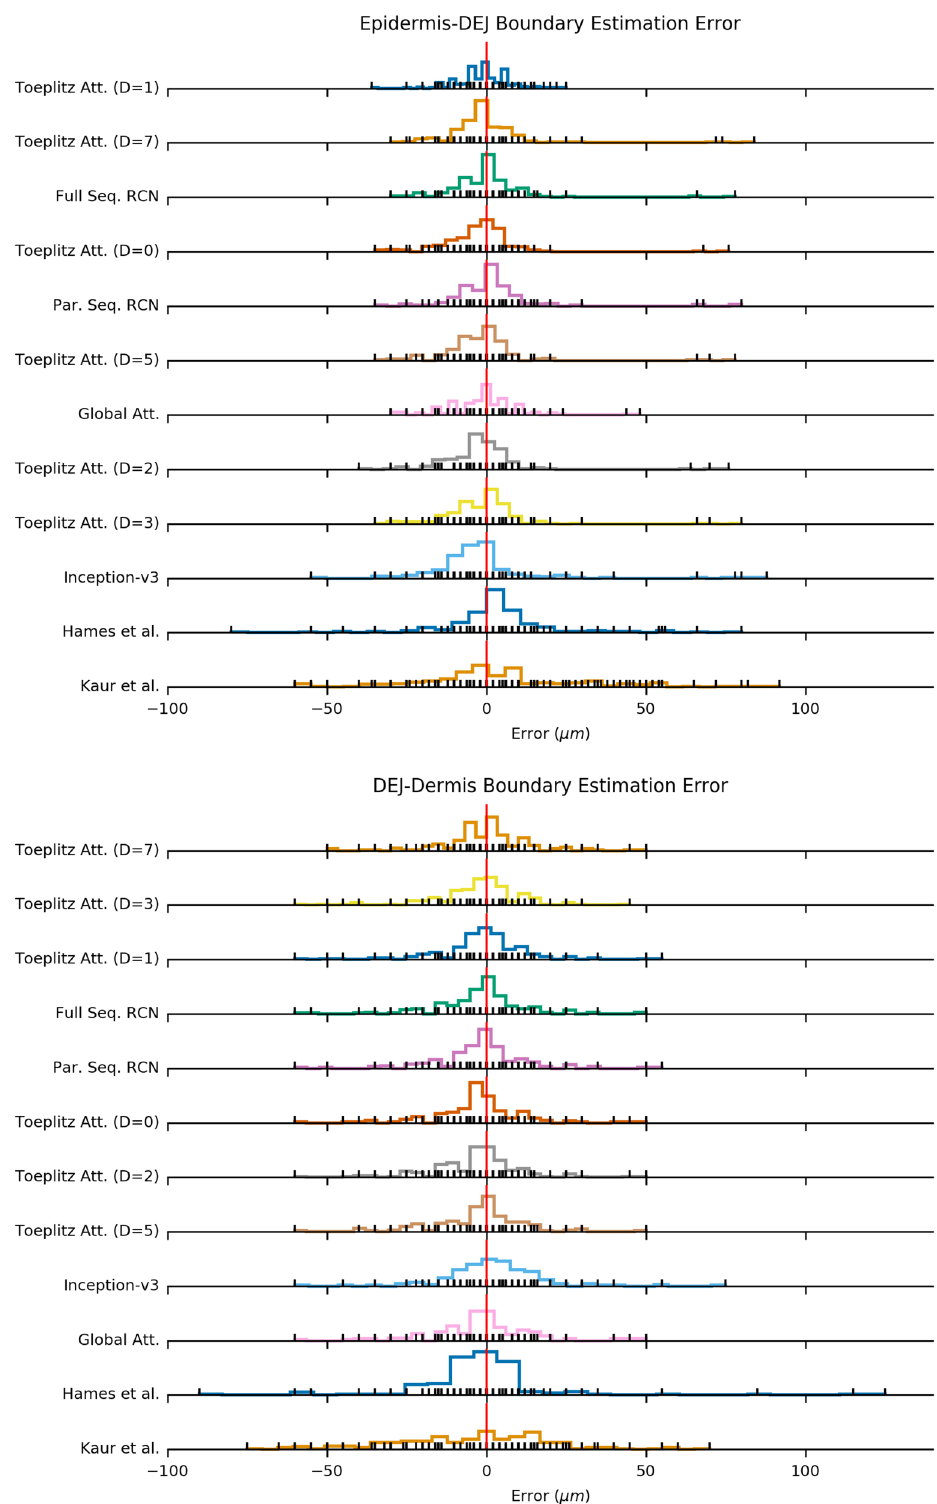
Figure 2. Histograms of error for the predictions of the epidermis-DEJ and DEJ-dermis boundaries for each model. Each black tick indicates a value of error that occurred in a test stack, colored lines show the distribution of errors, and red vertical line shows the origin. Models are sorted according to mean absolute